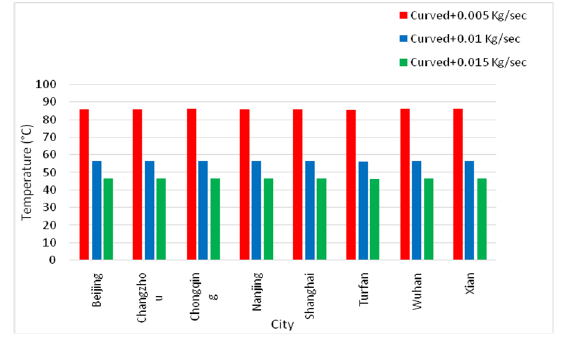
Fig. 3: Depart temperatures of functioning fluid regarding SCPC with eight unlike cities of China and varying